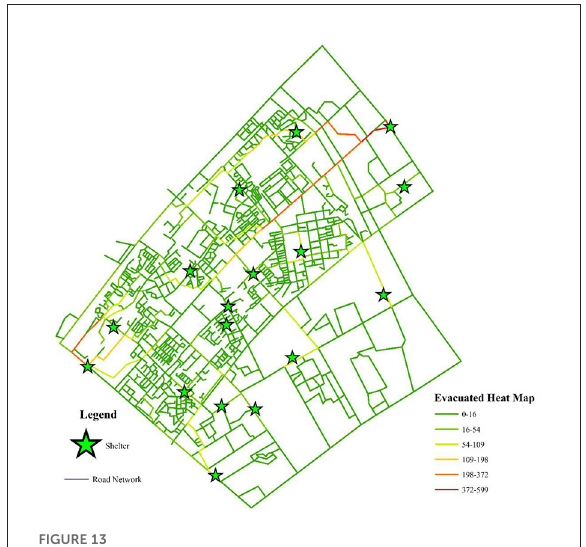
FIGURE13 Evacuation heat map of the road